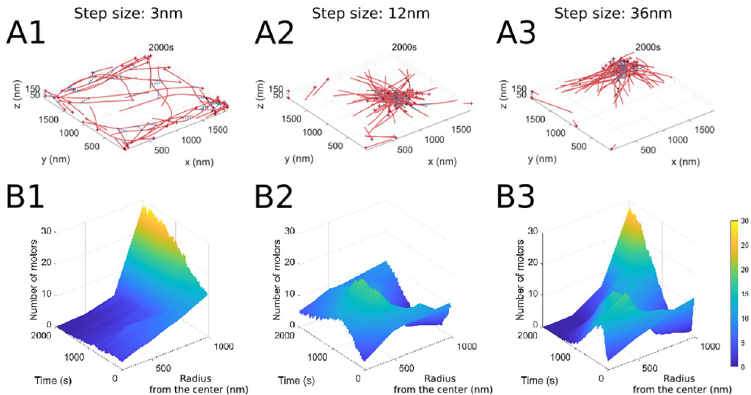
Fig 4. Increasing motor step size leads to actin filament clustering. (A) Final simulation snapshots ( t = 2000s) at the indicated motor step size ((A1): 3nm, (A2): 12nm, (A3): 36nm), showing aggregation of actin filaments for larger step sizes. (B) The corresponding motor localization over the whole domain for the different motor step sizes. The parameter values used are k head,bind = 0.2/s, F s = 100 pN, range heads = 15–30 (see Table